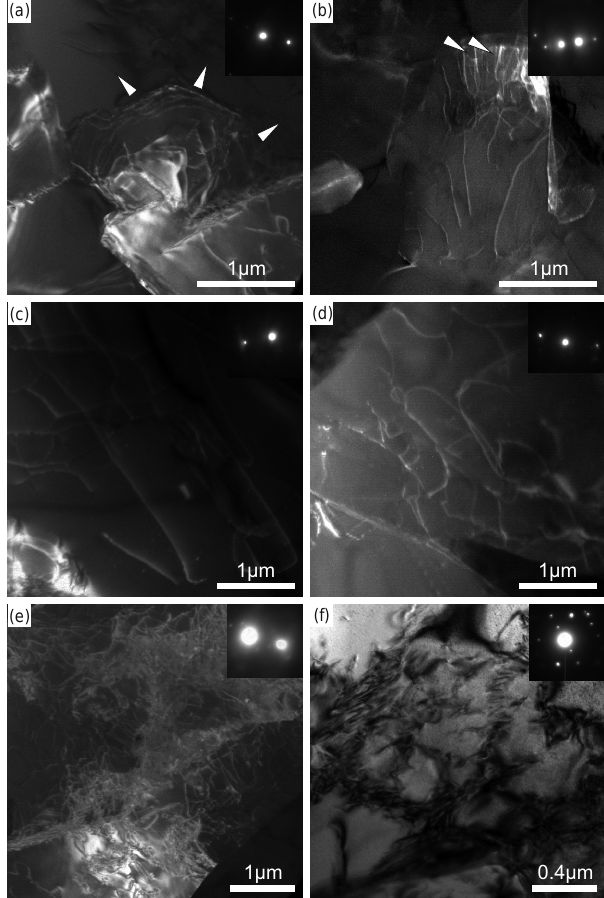
Figure 7. Typical TEM dislocation structures within the fine- grained ultramylonite. (a) Frank–Read source pinned at a grain boundary with multiplication and propagation of dislocation loops outward (arrows) on a f {01–12} glide plane; TEM dark field, g = 12 − 35. (b) Glide dislocations pinned at a grain boundary; TEM bright field, g = 0 − 114. (c) Extended glide dislocations. TEM dark field; g = 31 − 42. (d) Dislocation gliding in f-plane with notable dipole (arrow). TEM dark field; g = 1 − 32 − 4. (e) Typical high dislocation density in UFG calcite. TEM dark field; g = 30 − 33. (f) Cells (200nm structure) defined by dislocation arrays interpreted to be related to network-assisted recovery at low homologous temper- ature. TEM bright field; B ∼ [2 − 1 − 10] g = 0 −